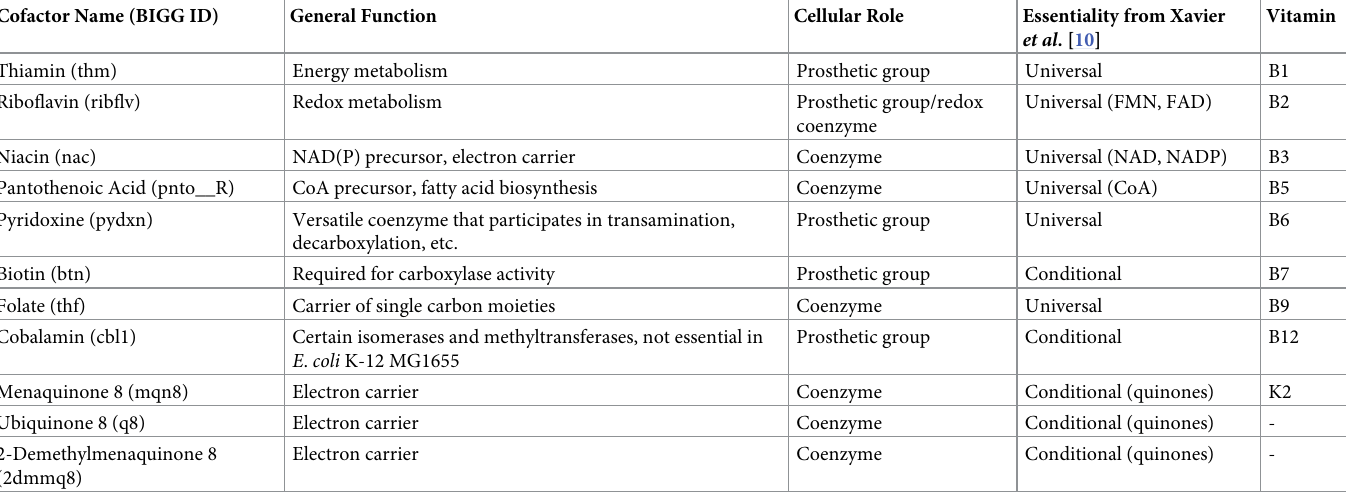
Table 1. Summary of the vitamins synthesized by E . coli K-12